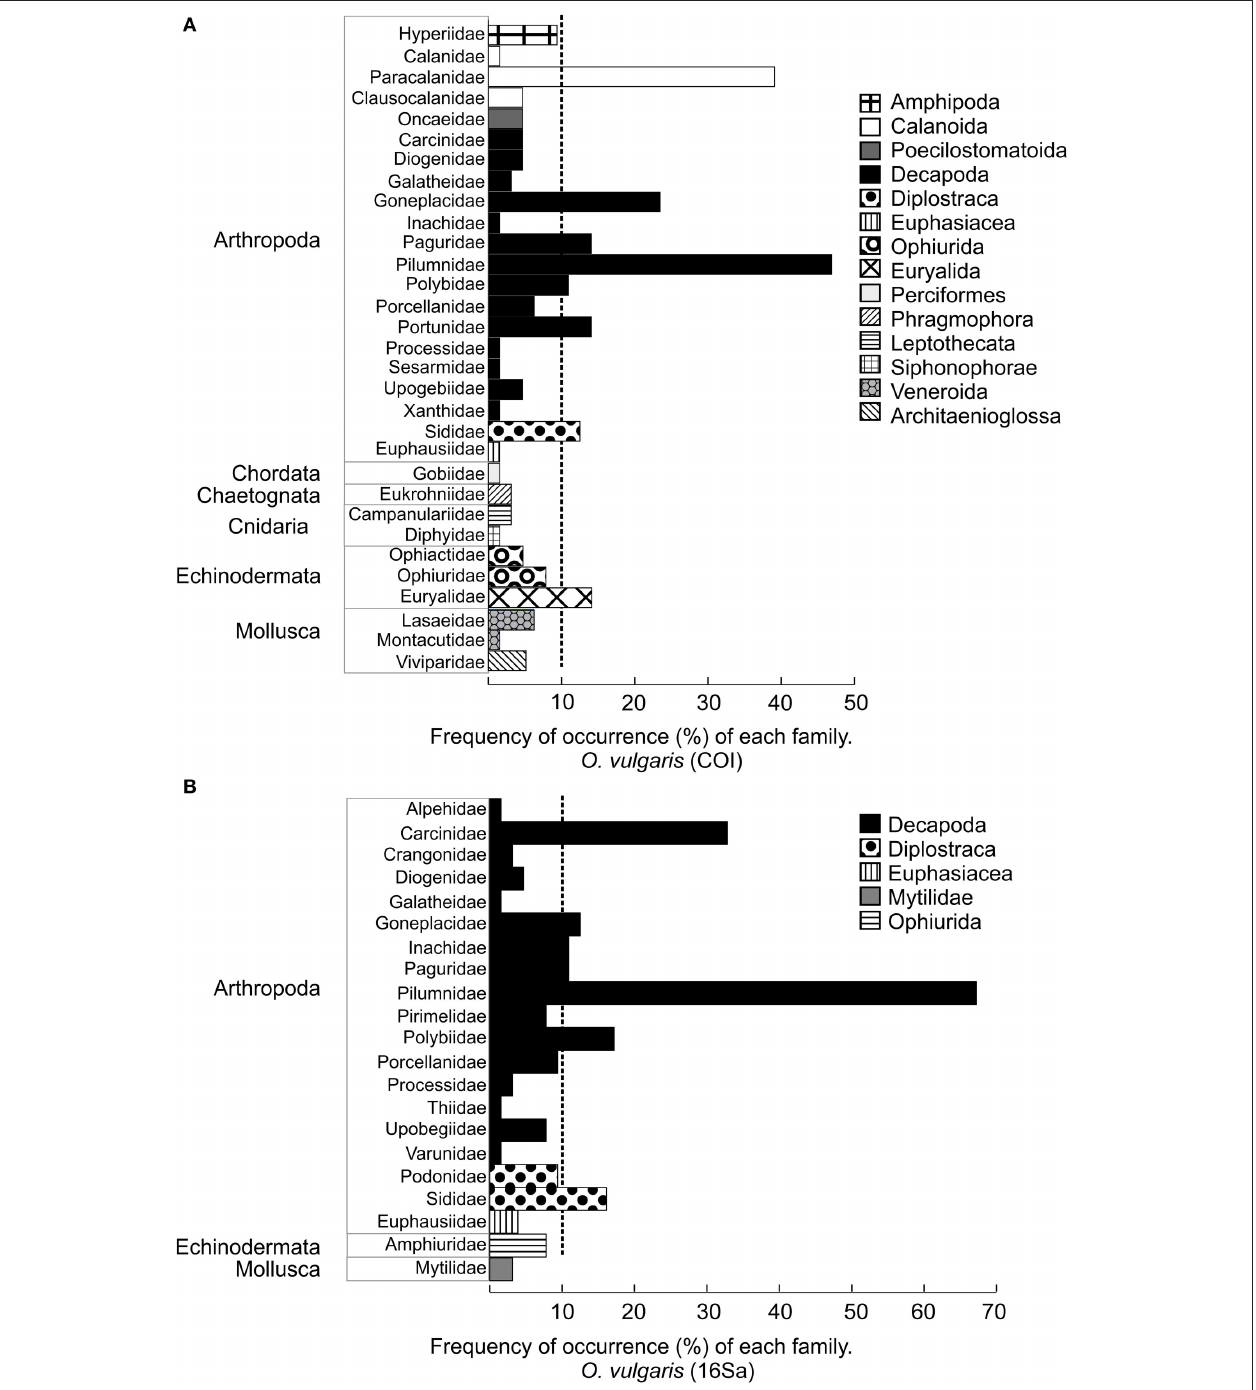
FIGURE 3 | Frequency of the occurrence of the families (FF) detected in O. vulgaris with primers COI (A) and primers 16Sa (B) with primer COI. Colors represent different orders. The corresponding phylum is indicated on the left. Vertical dashed line indicates the families detected in more than 10% of paralarvae.